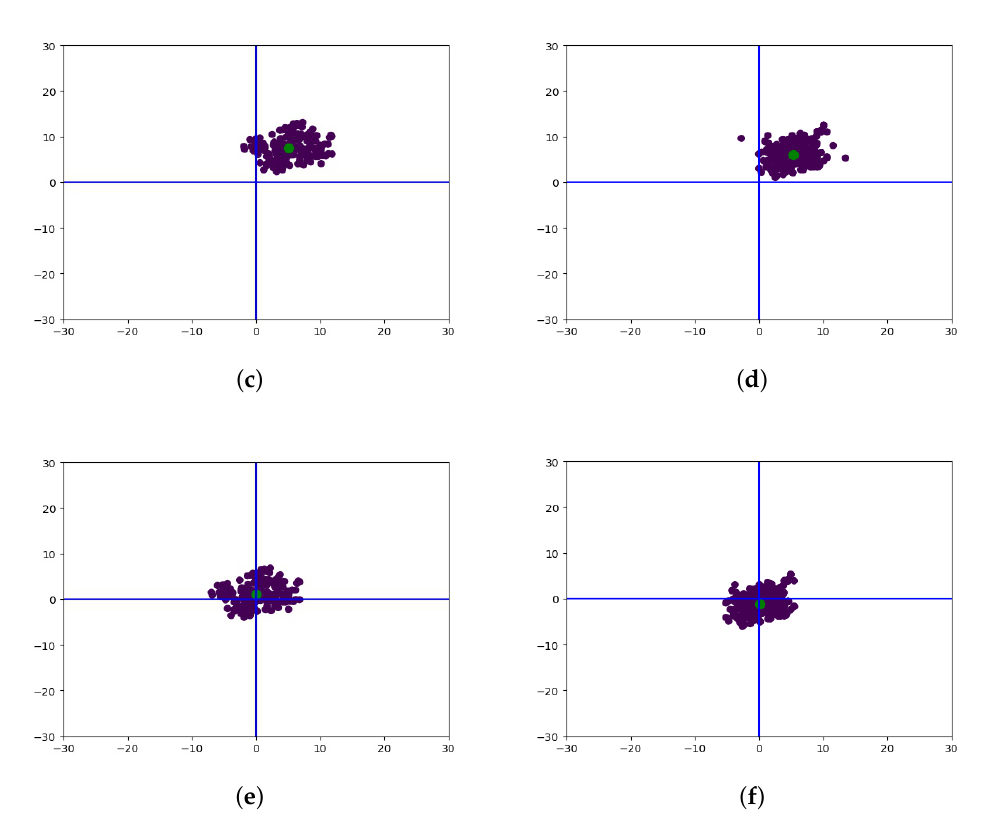
Figure 8. A Comparison of error distribution of all check points of Beijing and Songshan areas. ( a , b ) represent the original error distribution of Beijing and Songshan areas, respectively; ( c , d ) represent the residual error distribution after control point free block adjustment of Beijing and Songshan areas, respectively; ( e , f ) represent the error distribution after inherent error compensation of Beijing and Songshan areas, respectively.